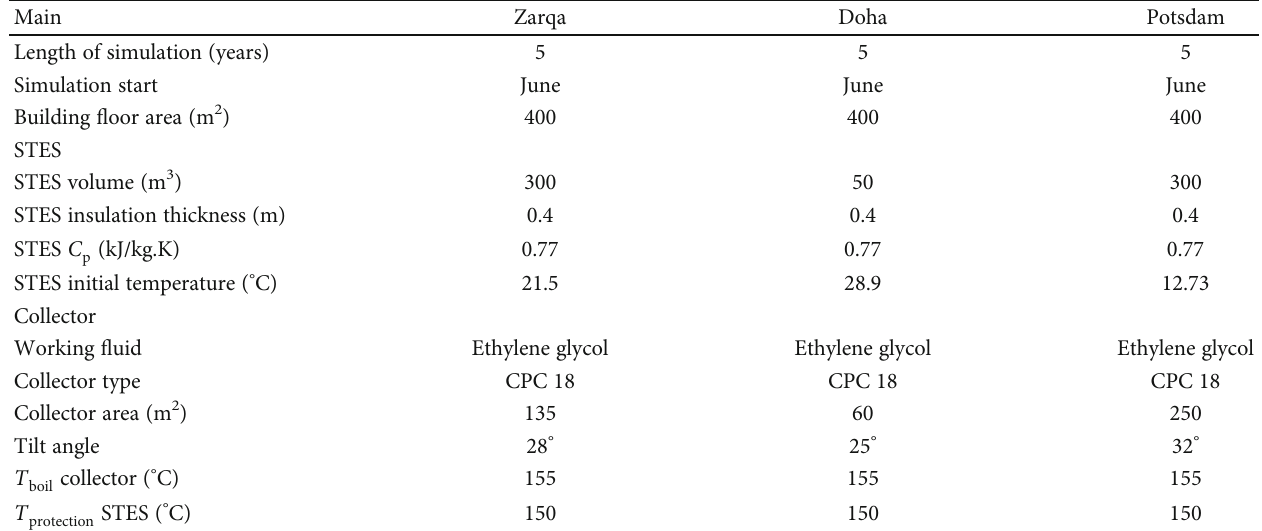
Table 5: TRNSYS® simulation